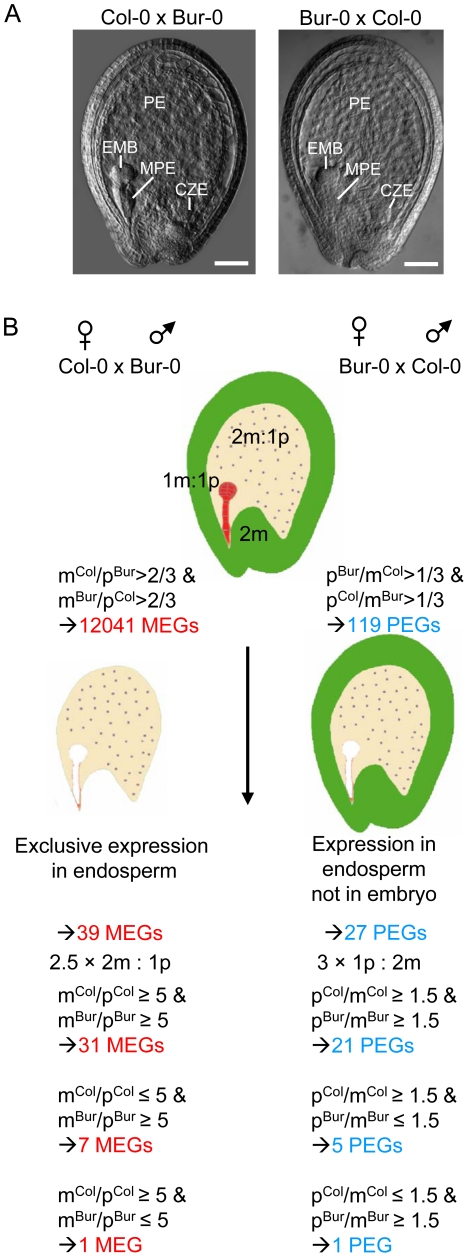
Scheme of Experimental Procedures Leading to the Identification of MEGs and PEGs in Arabidopsis.(A) Seeds derived after reciprocal crosses of Col-0 and Bur-0 accessions are phenotypically indistinguishable. Embyro (EMB), chalazal (CZE), micropylar (MPE) and peripheral (PE) endosperm are indicated. Scale bars, 50 µM. (B) Outline of filtering procedures leading to the identification of MEGs and PEGs.